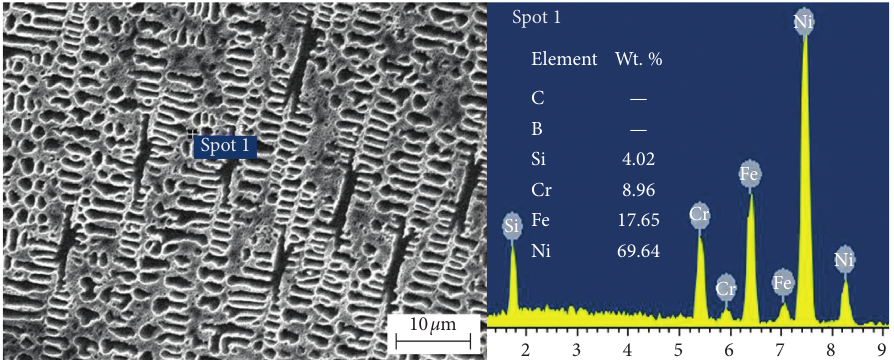
Figure 7: EDS analyses of the dendrites in C3